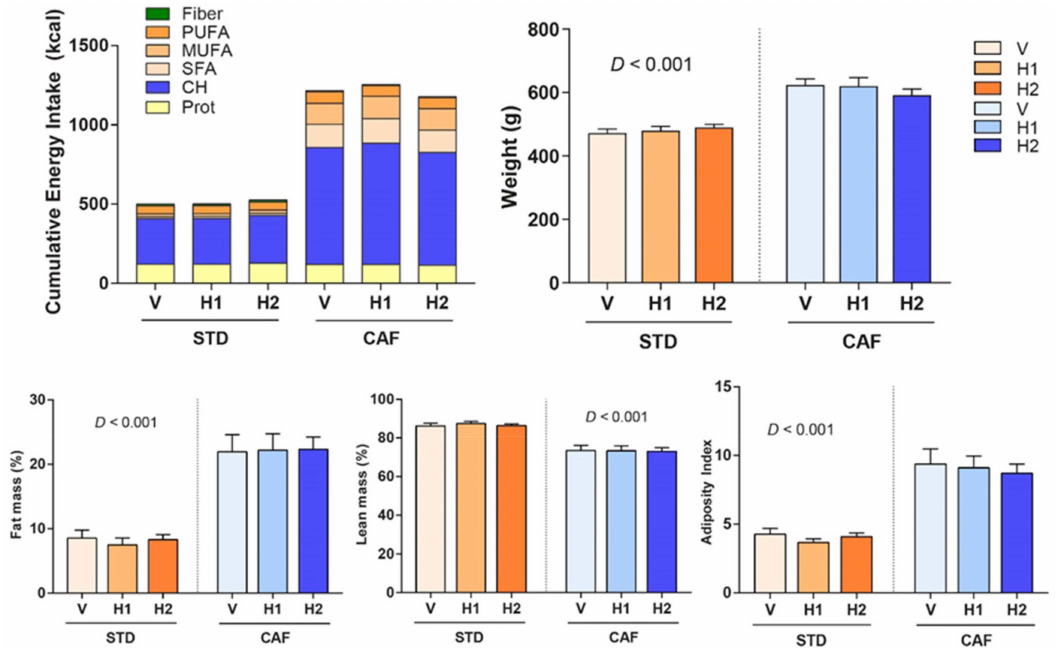
Figure 1. End point (week 18) cumulative energy intake, weight, fat mass, lean mass, and adiposity index of rats that were fed with a standard (STD) or a cafeteria (CAF) diet and received a daily oral dose of vehicle (V), hesperidin at 40 mg / kg (H1), or hesperidin at 100 mg / kg (H2), for the last eight weeks. Data are given as means ± SEM. CH, carbohydrates; D , Diet e ff ect; MUFA, monounsaturated fatty acids; Prot, proteins; PUFA, polyunsaturated fatty acids; SFA, saturated fatty